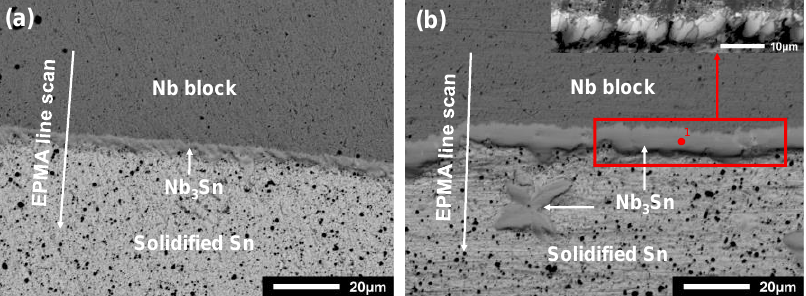
Figure 2. BSE images of Nb/Sn LSDCs annealed ( a ) at 1100 °C for 2.33 h, and ( b ) at 1200 °C for 2 h.